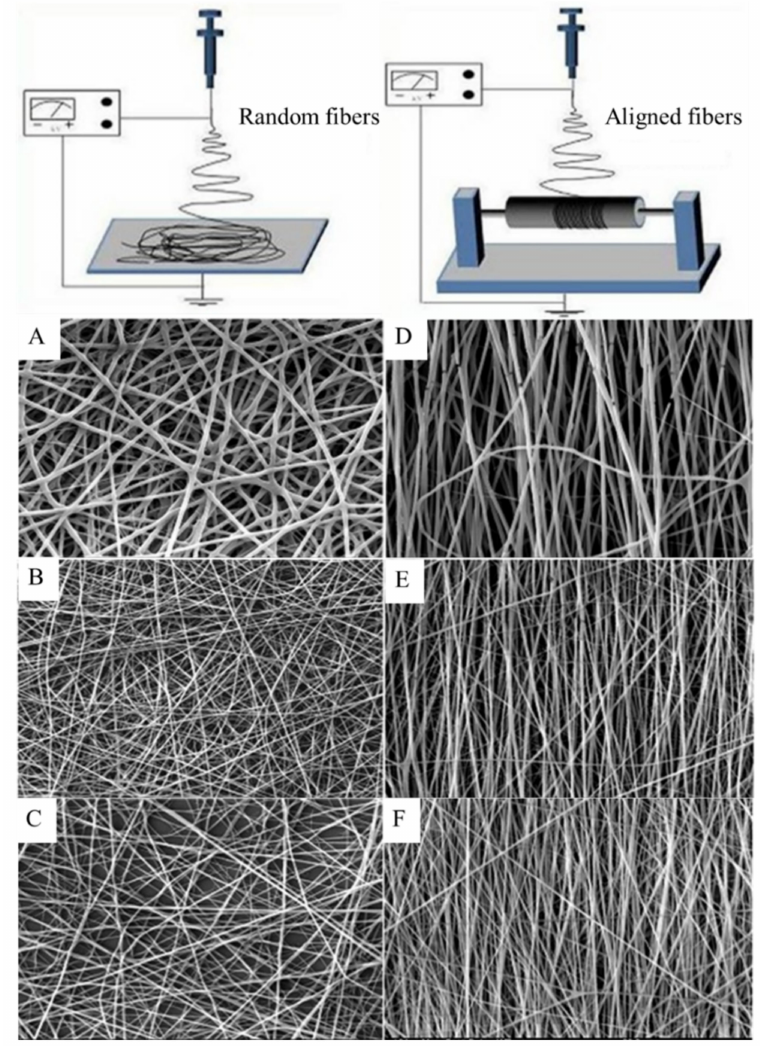
Figure 11. Optimizing the electrospinning conditions, either aligned or random nanofibers can be obtained.